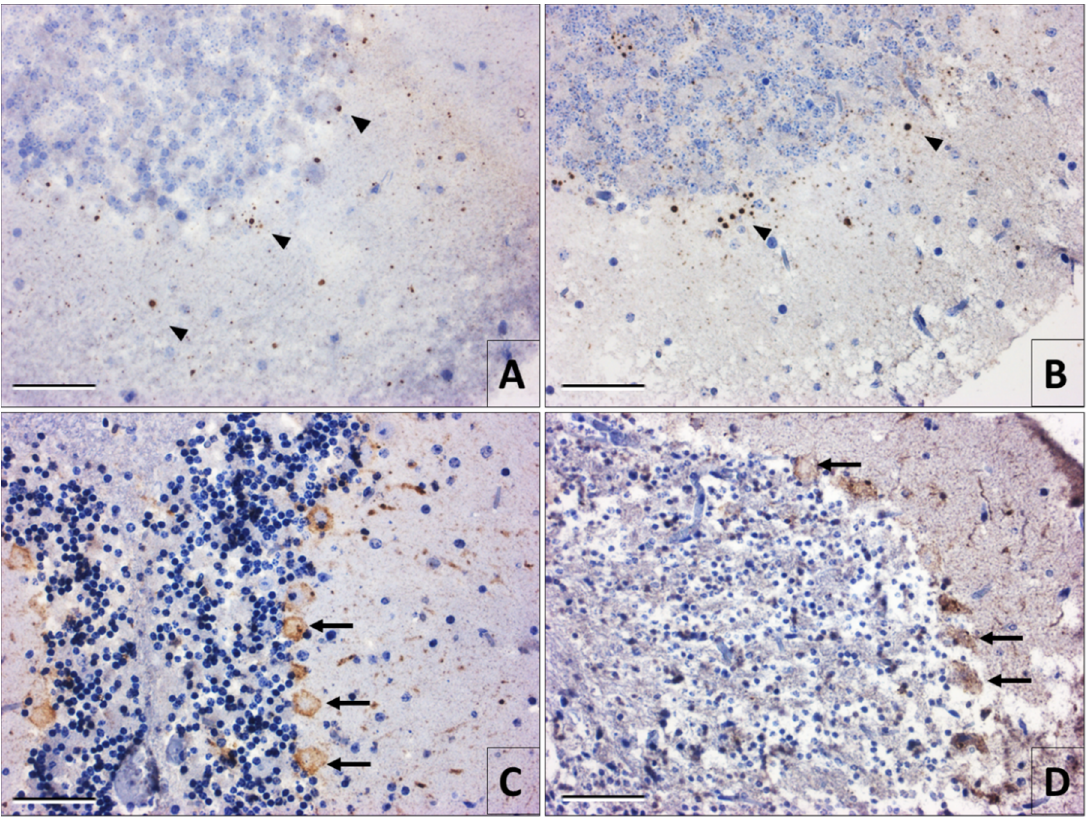
Figure 3. Immunohistochemistry for rabies in cerebellar slices (7 µm) embedded in paraffin. Tissue fixed by perfusion ( A ) and immersion ( B ) at 0 h postmortem. Many intracytoplasmic viral inclusions are observed in the area of the Purkinje cells (arrowheads), but the cellular morphology is not clear. In samples fixed at 12 h postmortem ( C ), immunostaining delimits the profile of the neuronal soma (arrows). At 30 h postmortem ( D ), the tissue presents degradation, but immunoreactivity is preserved in the soma (arrows) and some dendrite fragments of the Purkinje cells (Magnification A-D 40×) (bars = 50 µm).